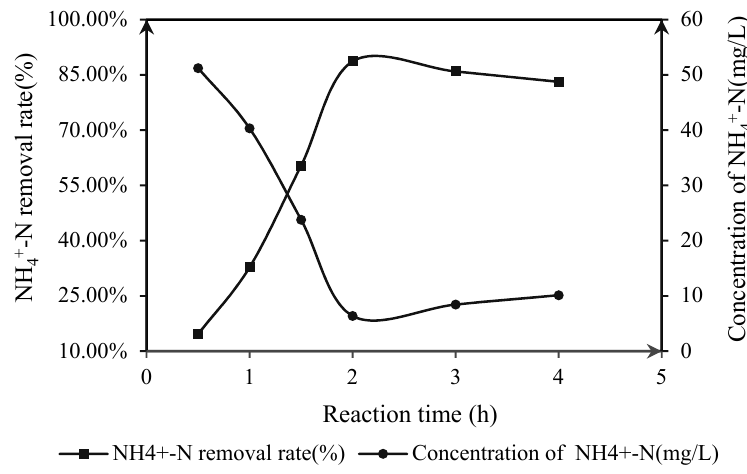
Figure 9. Under UV direct irradiation conditions.